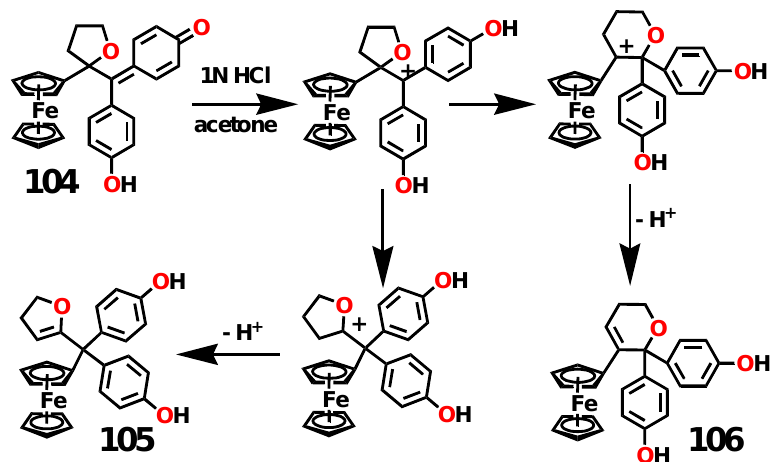
Scheme 34. Ferrocenyl migration and ring expansion upon protonation of the tetrahydrofuranyl- quinone methide, 104 . quinone methide, 104 .